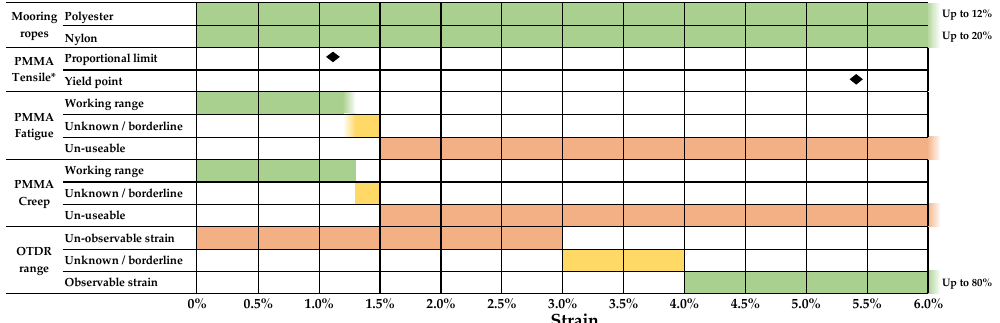
Figure 19. Summary graphic detailing the useable range of synthetic mooring ropes alongside the results from this study. Green indicates a working range, yellow an unknown/borderline range and red an unusable range. * Tensile results for strain rate of 0.25 strain/min.